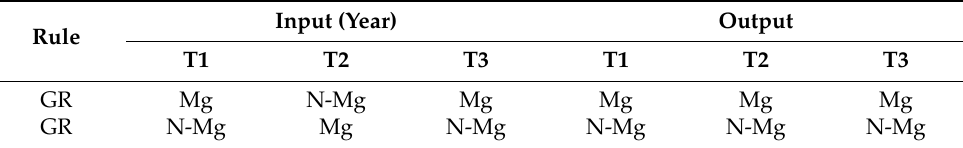
Table 2. The temporal filter inspects the central position of three consecutive years, and in cases of identical extremities, the centre position is reclassified to match its neighbour. T1, T2 and T3 stand for positions one (1), two (2) and three (3), respectively. GR means “generic rule”, while Mg and N-Mg represent mangrove and non-mangrove pixels.